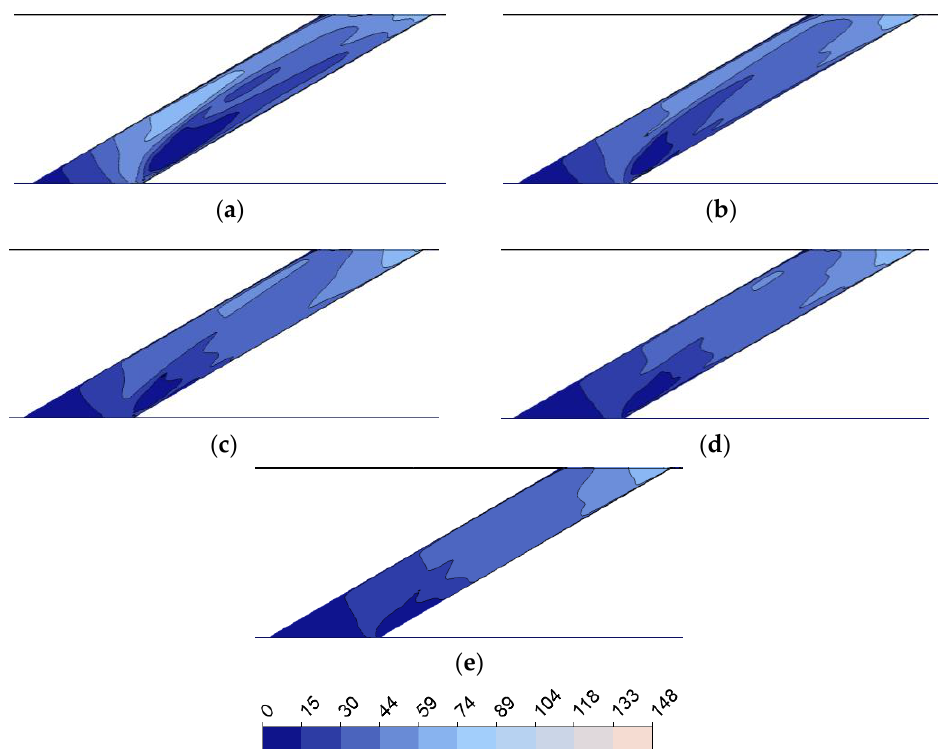
Figure 13. 𝜂 𝑠 with expansion to the sides of the inlet hole.